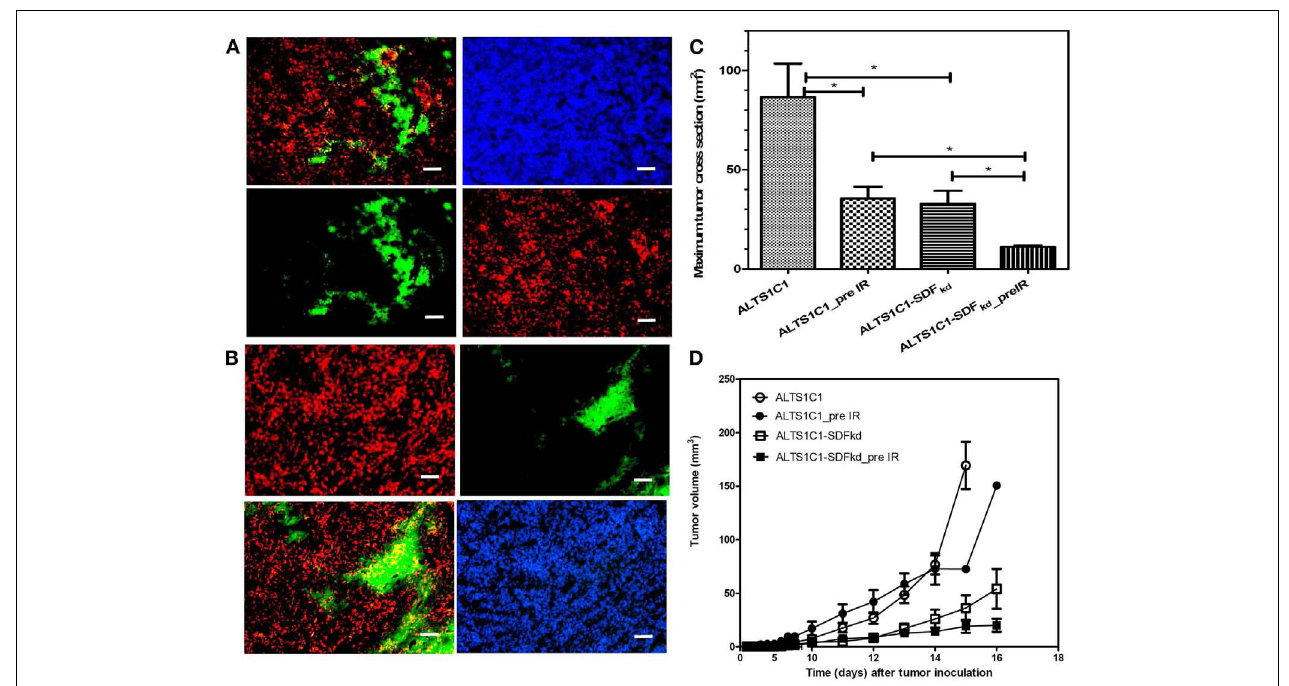
FIGURE 9 | Suppression of SDF-1 expression byALTS1C1 tumor disrupts pre-IR-inducedTAM association with hypoxia in both i.c. (A) and i.m. (B) models and prolong pre-IR-induced growth delay in both i.c. (C) and i.m.